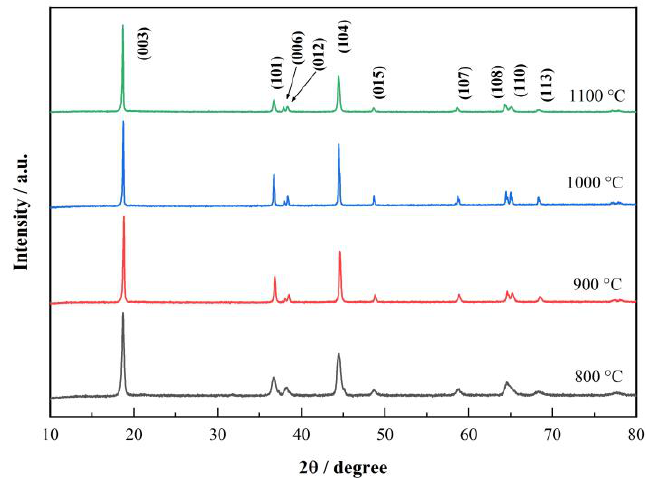
Figure 3. XRD spectra of LiNi 0.5 Co 0.2 Mn 0.3 O 2 synthesized at 800 °C, 900 °C, 1000 °C and 1100